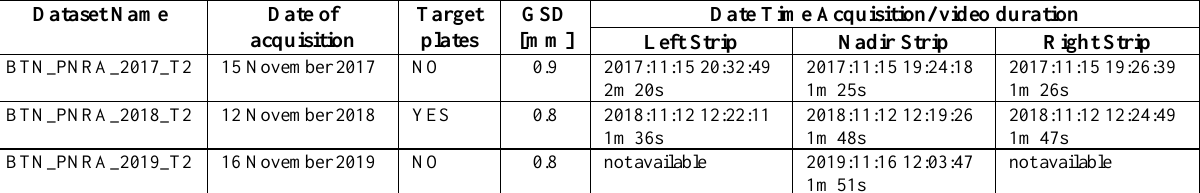
Table 1 . Underwater photogrammetry dataset used for the